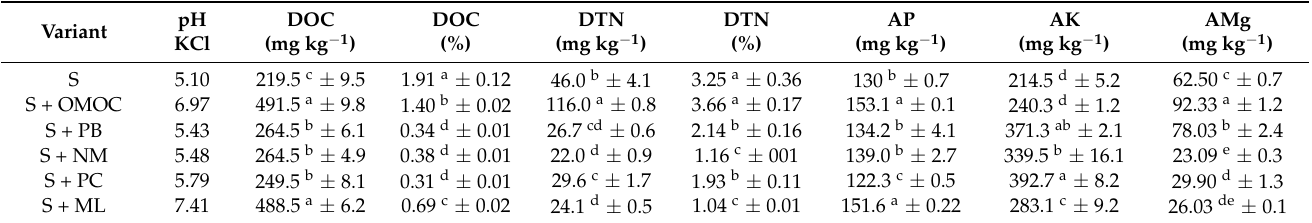
Table 3. Values of pH in KCl, content and share of dissolved organic carbon and nitrogen, and available phosphorus, potassium and magnesium (after 60 days